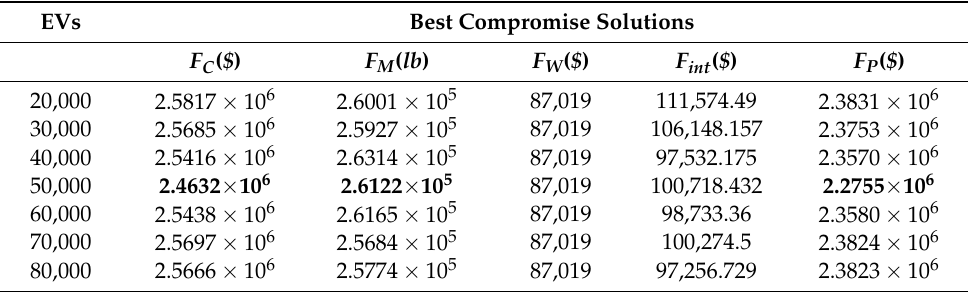
Table 13. The best compromise solutions obtained with different scales of